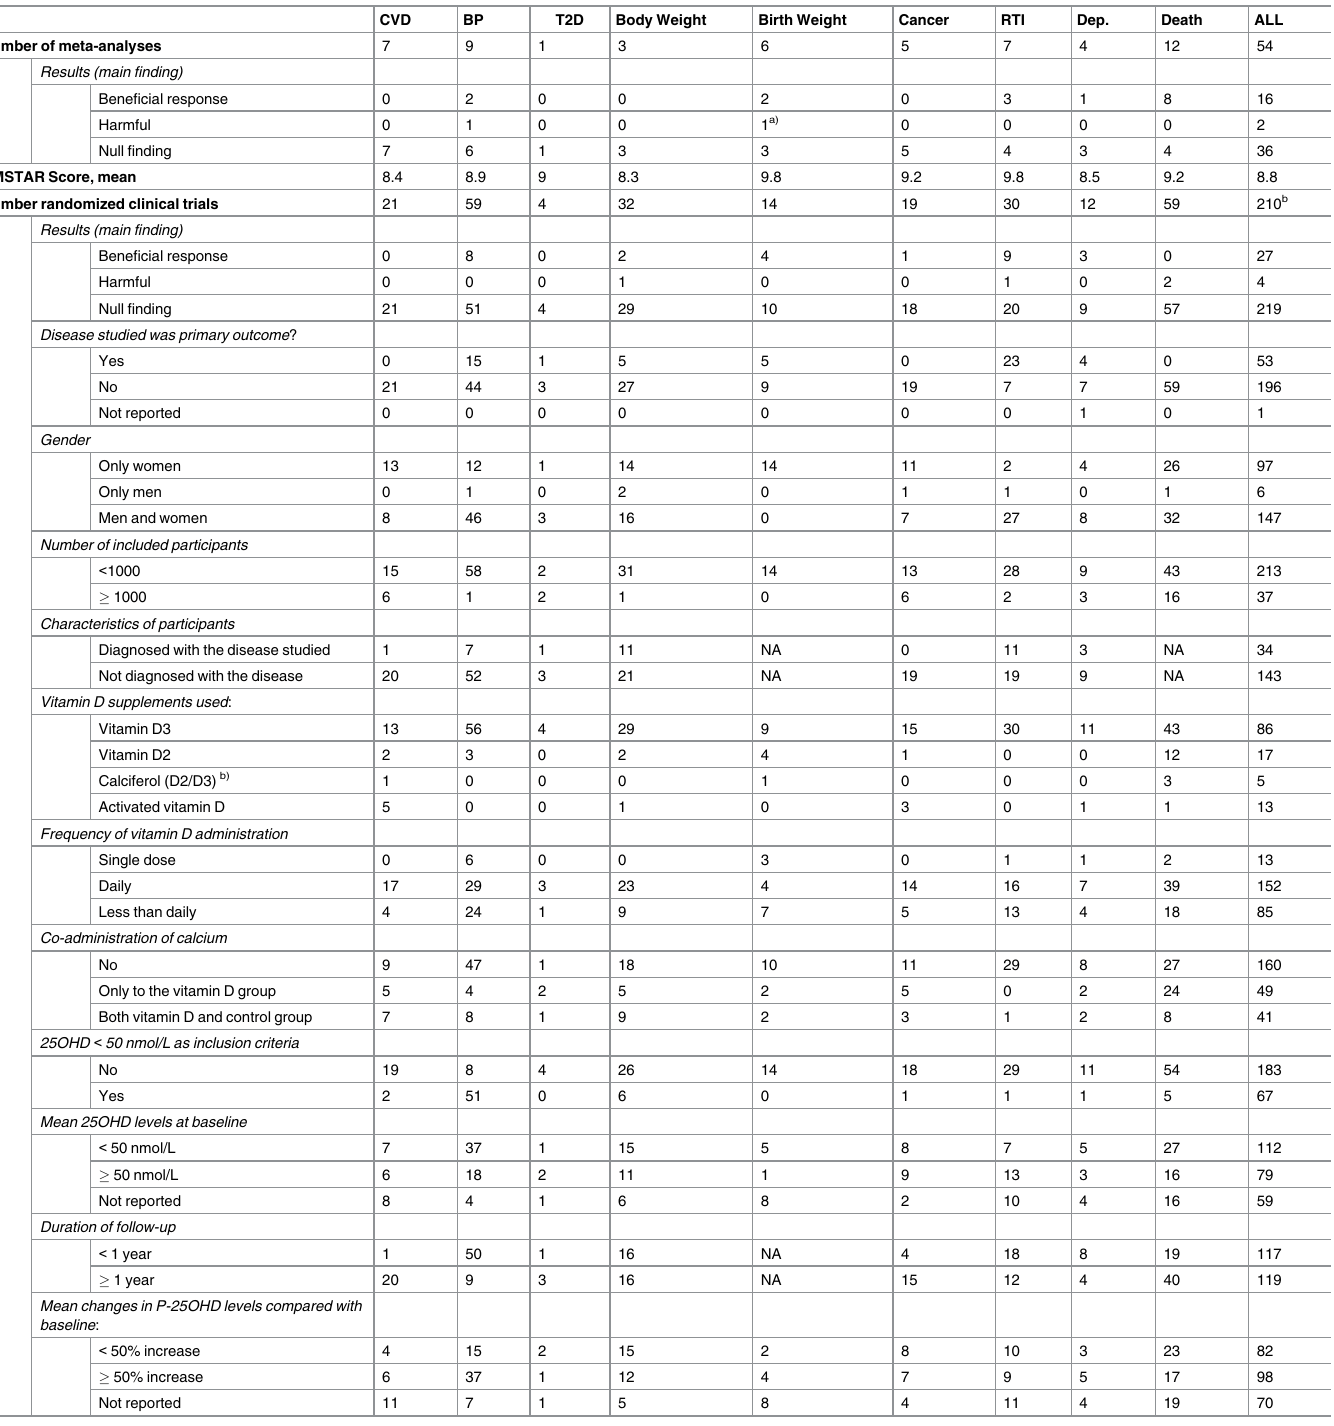
Table 1. Summarycharacteristics of meta-analyses and the individual RCTs included in MA on non-skeletal effects of vitamin D supplementation.